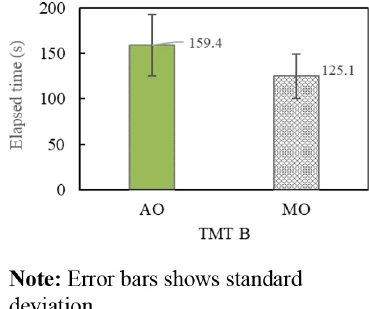
Figure 7 Results of elapsed time for